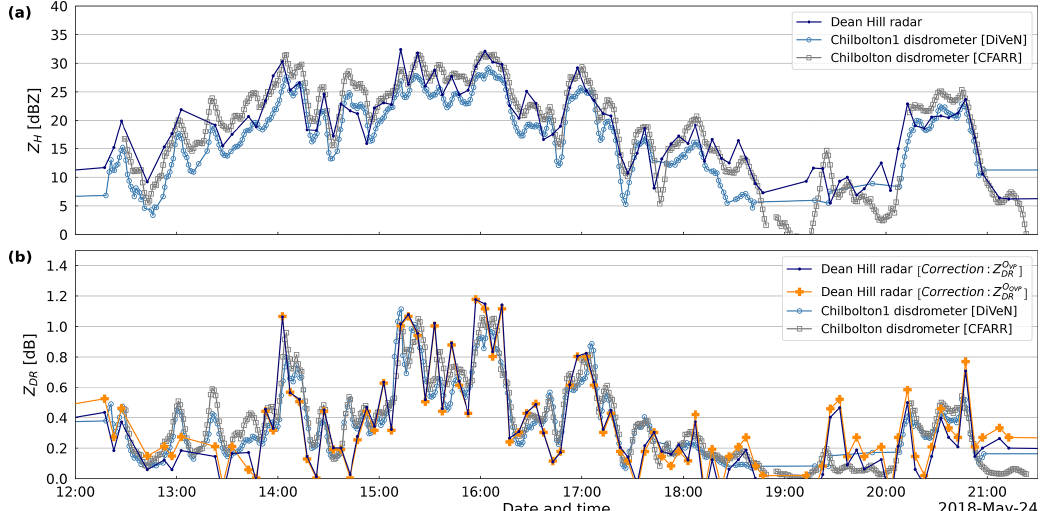
Figure 10. Time series of disdrometer and radar data related to a precipitation event registered in southern England: (a) reflectivity ( Z H ) simulated from disdrometer DSD data at two nearby locations and Z H measured by the C-band Dean Hill weather radar at an angle elevation of 2 ◦ ; (b) differential reflectivity ( Z DR ) measured by the Dean Hill radar and offset-corrected using two different approaches and Z DR simulated from two